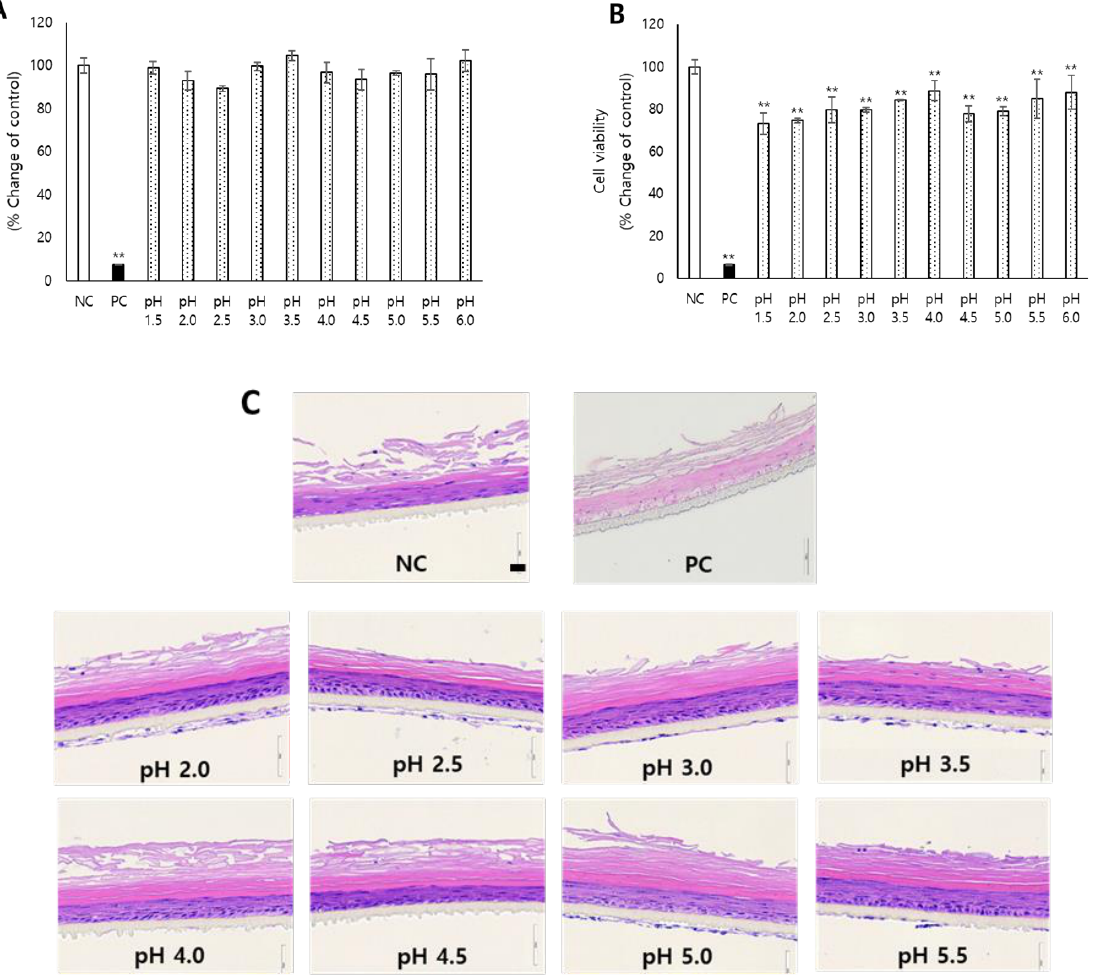
Figure 1 . In this figure, 0.1 M McIlvaine buffers prepared with indicated pH ranges were treated with KeraSkin™ for ( A ) 30 and ( B ) 180 min, and cell viability was measured with an MTT assay. See Methods for detailed procedure. ( C ) KeraSkin™ treated with test chemicals was stained with H&E. Scale bar is 50 μm. NC; negative control (DW) with white bars, PC; positive control (5% SDS) with filled bars. McIlvaine buffers with dotted bars ** p < 0.01.